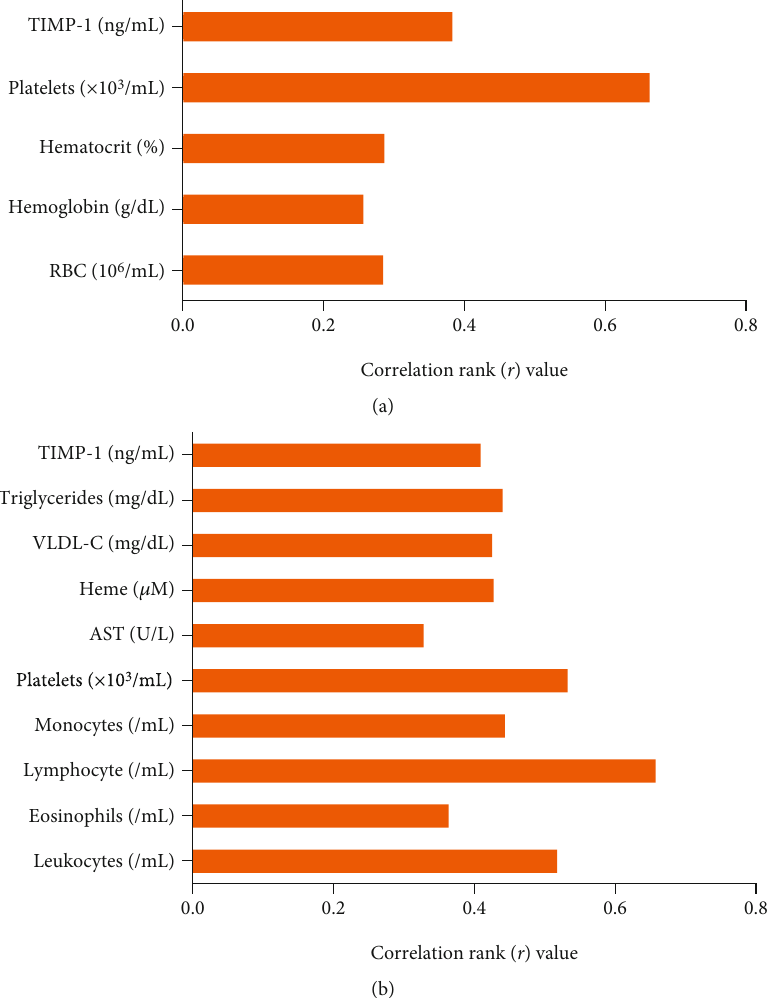
Figure 2: Correlations between TGF- β 1 levels and laboratory biomarkers in individuals with HbSS and HbSC. (a) Positive correlations between TGF- β 1 levels and RBC, Hb, Ht, platelet, and TIMP-1 in individuals with HbSS. (b) Positive correlations between TGF- β 1 levels and leukocytes, eosinophils, lymphocytes, monocytes, platelets, AST, VLDL-C, triglycerides, heme, and TIMP-1 in HbSC